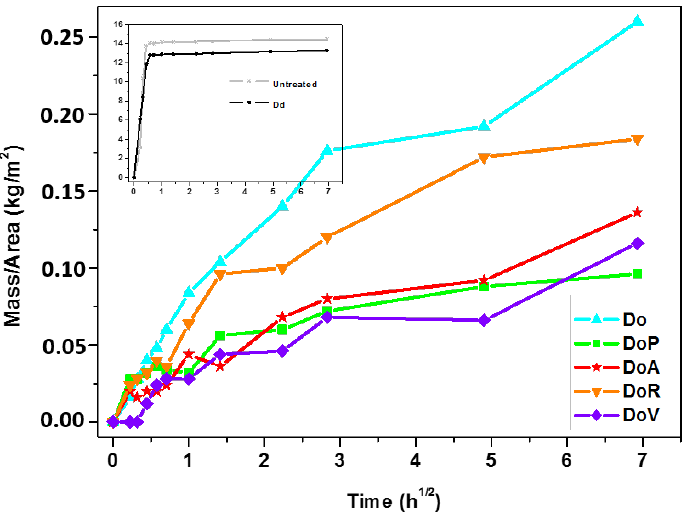
Figure 7. Water absorption by capillarity for stone samples treated with consolidants.